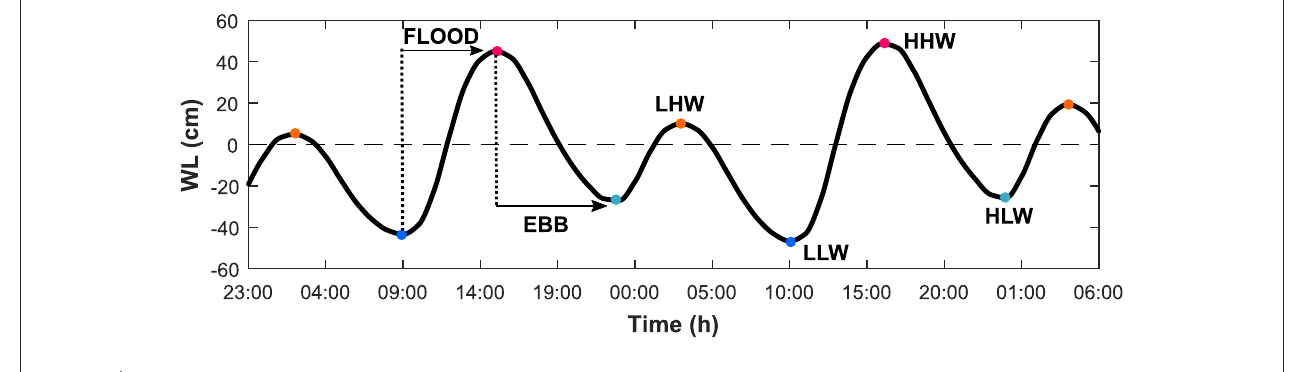
FIGURE 1 | Diagram of the tidal levels and phases of the tidal curve analyzed.